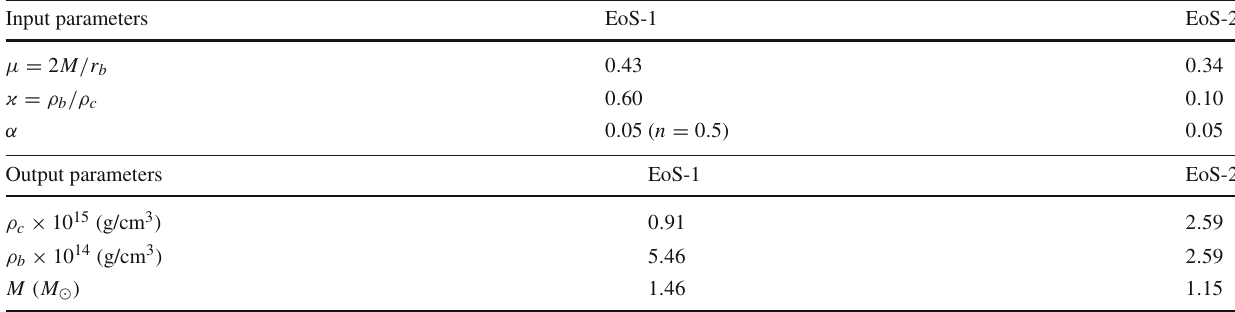
0.18 approximately. The model EoS-1 could describe the mass of the millisecond pulsar in SR J1738+0333. The mass for the EoS-2 com- pact object is close to the lowest-mass-pulsar J0453+1559 companion (1 . 174 ± 0 . 004 M (cid:14)